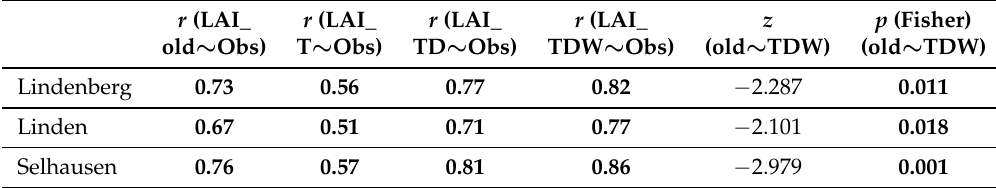
Table 2. Pearson’s correlation coefficient r for the monthly LAI of the different simulations from 1999 to 2015 compared to satellite observations (significant in bold), Fisher’s z for Pearson’s r of the standard simulation compared to the new phenology, and the p -value calculated from Fisher’s z (significant in